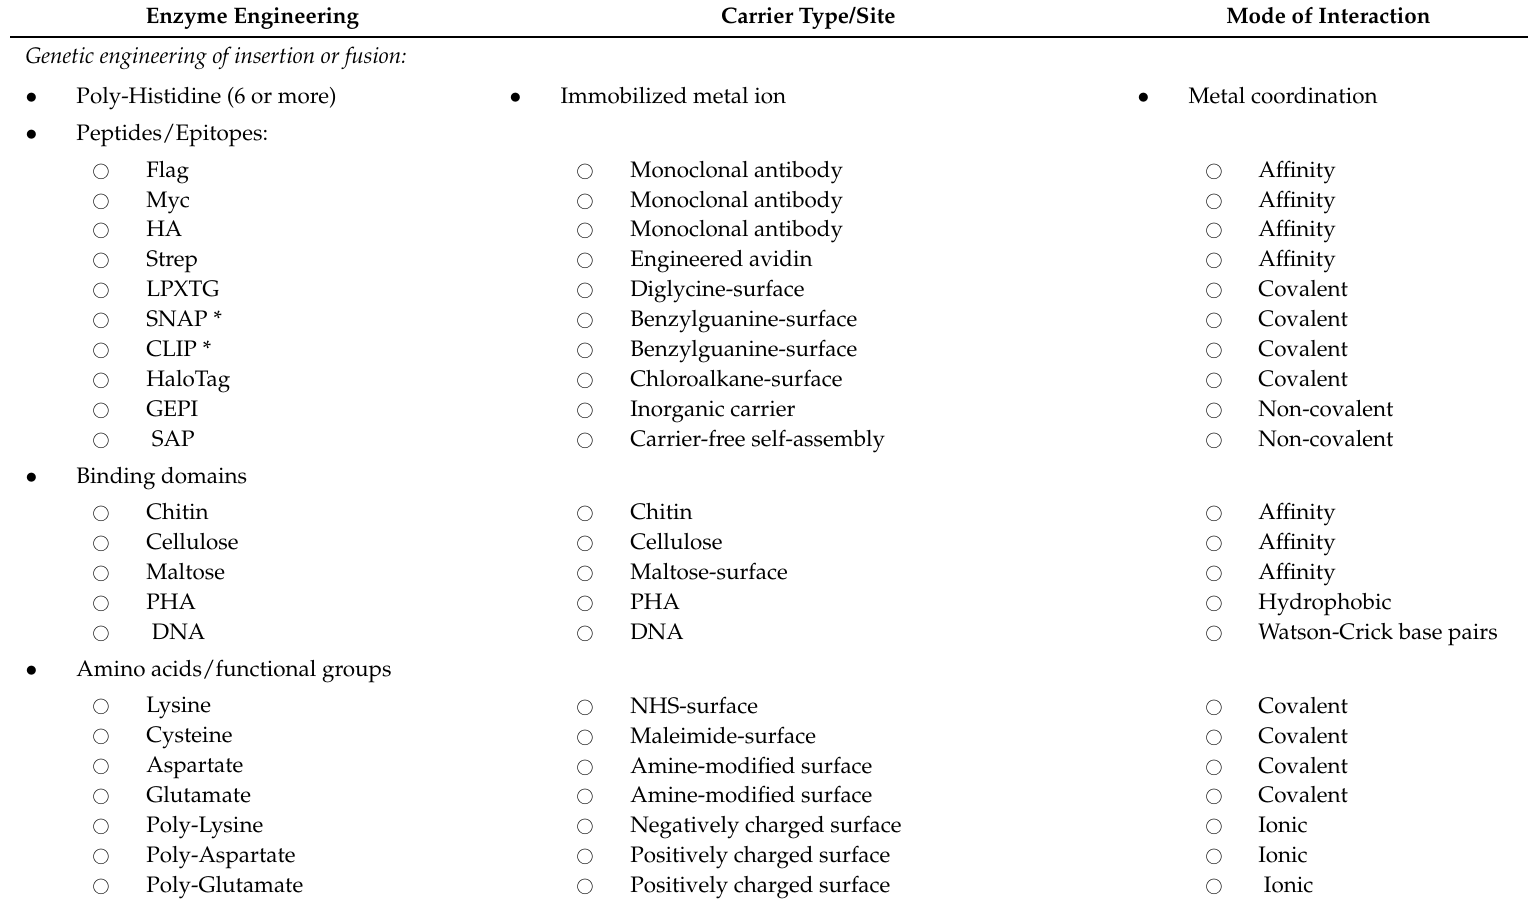
Table 1. Enzyme engineering towards site-specific